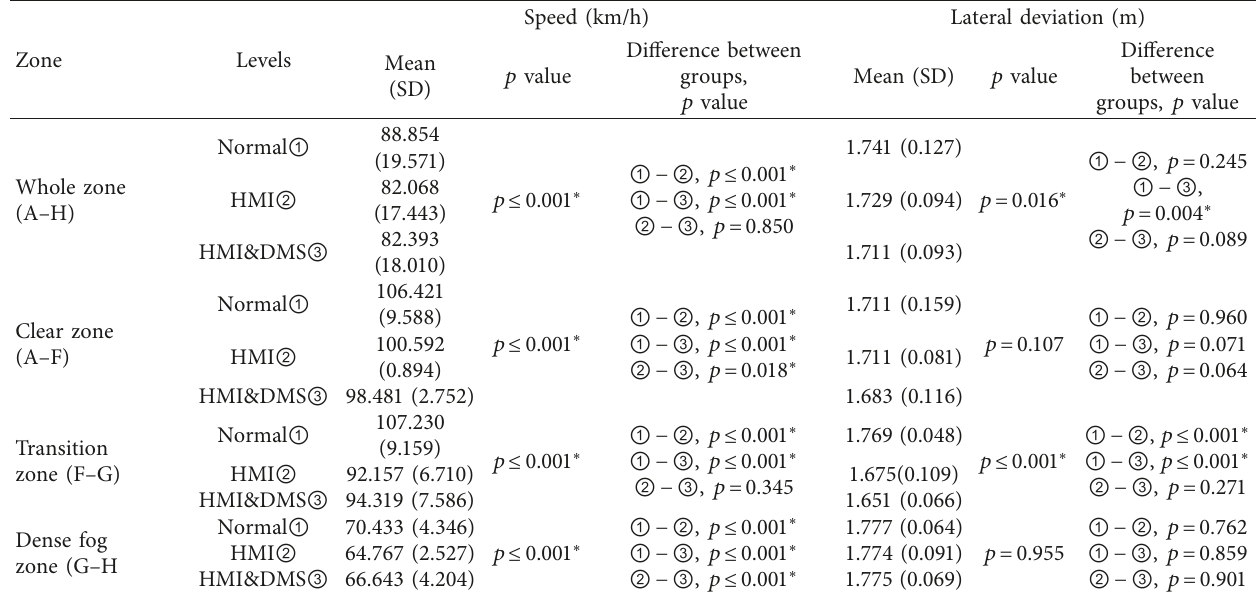
Table 3: Statistical analysis of index under fog